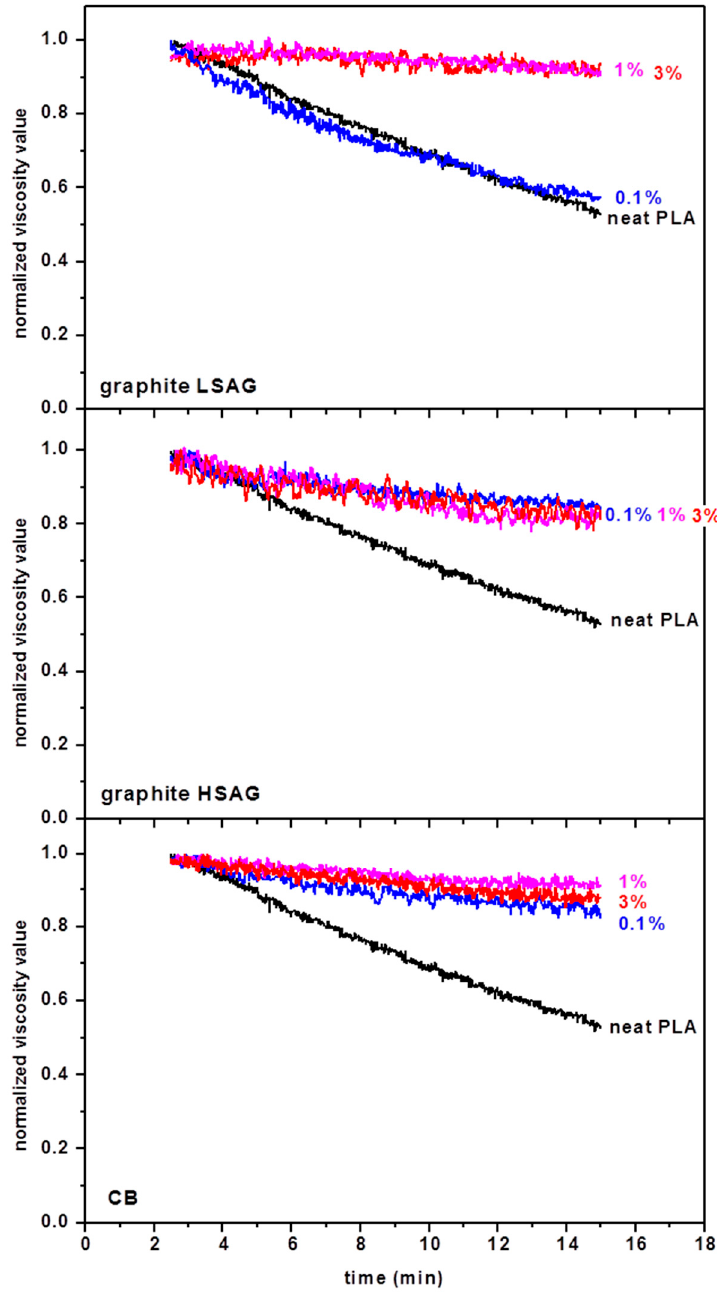
Figure 2. Time evolution of normalized viscosity (with respect to the initial value) in the microcompounder at T = 200 °C and 100 rpm. The estimated value of shear rate is about 350 s − 1 . GPC curves of PLA pellet and of extruded PLA compounds, with different kinds and amounts of carbon fillers, are shown in Figure 3.